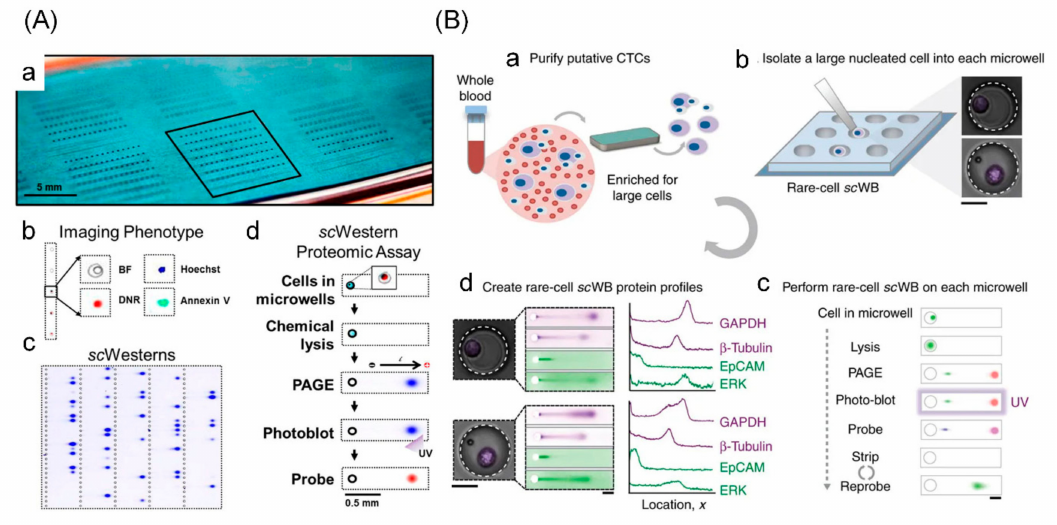
Figure 6. Single-cell Western blotting for single-cell protein analysis. ( A ) Schematic of single-cell phenotype imaging and Western blotting. (a) The array consists of thousands of microwells patterned in a thin layer (30 µ m) photoactive polyacrylamide gel seated on a glass slide; (b) fluorescent imaging of single cells in microwells provides phenotype information; (c) single cells are lysed in situ after imaging and the lysate is used for Western blot analysis; (d) workflow of single-cell Western blotting for proteomic assay. Adapted with permission from [100]. ( B ) Single-cell Western blotting of rare cells. (a) Enrich circulating tumor cells (CTCs) from whole blood samples based on cell size; (b) deposit enriched cells into the microwell and identify each CTC by nuclear staining; (c) for each cell in microwell, proceed as in-microwell chemical CTCs lysis, single-CTC protein polyacrylamide gel electrophoresis, covalent immobilization of proteins to the gel (photo-blotting) and in-gel immunoprobing; (d) single-CTC lysate is analyzed and rounds of immunoprobing support the multiplexing of 12 proteins, thus creating a protein expression profile for each rare cell. Adapted with permission from